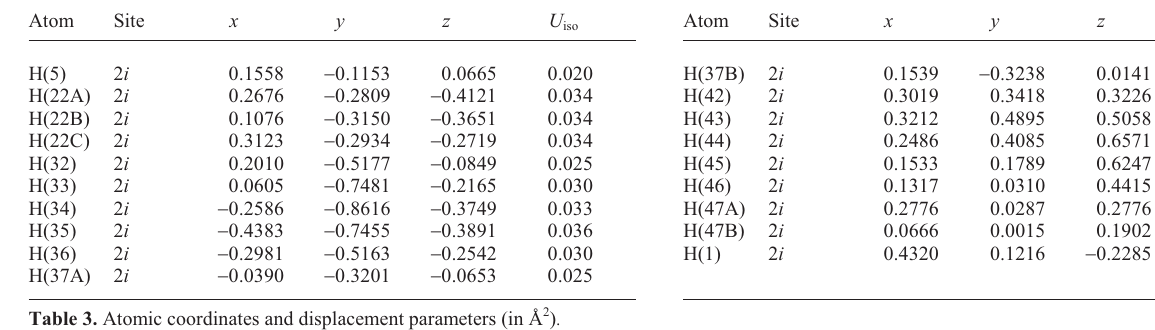
Table 2. Atomic coordinates and displacement parameters (in Å 2 ) .